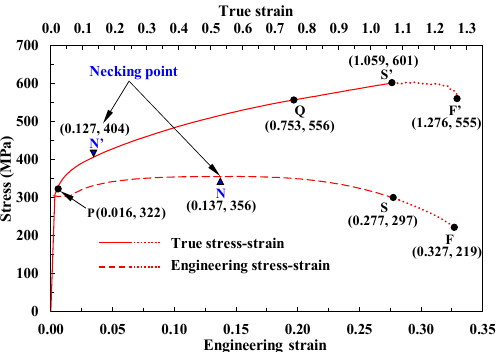
Figure 1. Experimental engineering stress–strain curve of SWCH10A and its associated true stress– strain curve (RFS) [10]. The dot curves were considered as the ductile fracture-effective region. N, S, and F in Figure 1 correspond to the necking, softening, and fracture points, respectively; P and Q are the selected points, left and right of N’, respectively, which are necessary to calculate material constants. The first and second values within the brackets are the engineering or true strain and its corresponding stress, respectively. For example, necking occurred at an engineering strain of 0.137 and a tensile strength of 356